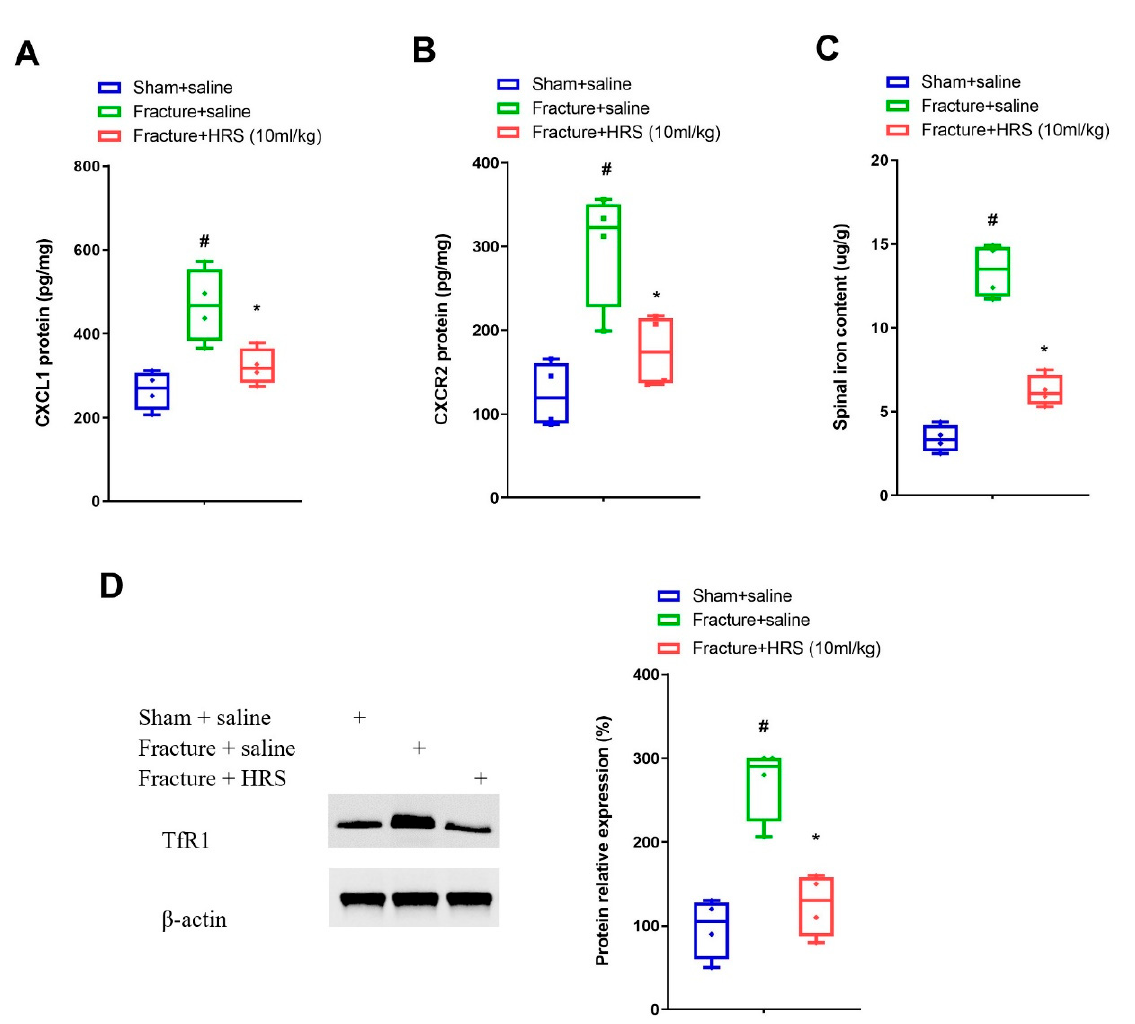
Figure 2. Repetitive injections of HRS reduce spinal CXCL1/CXCR2 expression and TfR1-dependent iron overload. Intraperitoneal (i.p.) hydrogen-rich saline (HRS, 10 mL/kg) was injected daily for 3 consecutive days on days 4, 5 and 6 (indicated by red arrows) after tibial fractures. ( A , B ) Elisa assay showed the changes of spinal CXCL1 and CXCR2 levels on day 7 following tibial fracture and HRS injections, respectively. ( C ) Spinal iron concentration on day 7 following tibial fracture and HRS injections was measured using atomic absorption spectrophotometer. ( D ) Western blot showed the changes of spinal TfR1 on day 7 following tibial fracture and HRS injections. Results are expressed as medians with interquartile ranges and individual data plots ( n = 4). The biochemical data are analyzed by one-way ANOVA with Bonferroni post hoc comparisons. # p < 0.05 vs. group Sham + saline, * p < 0.05 vs. group Fracture + saline.